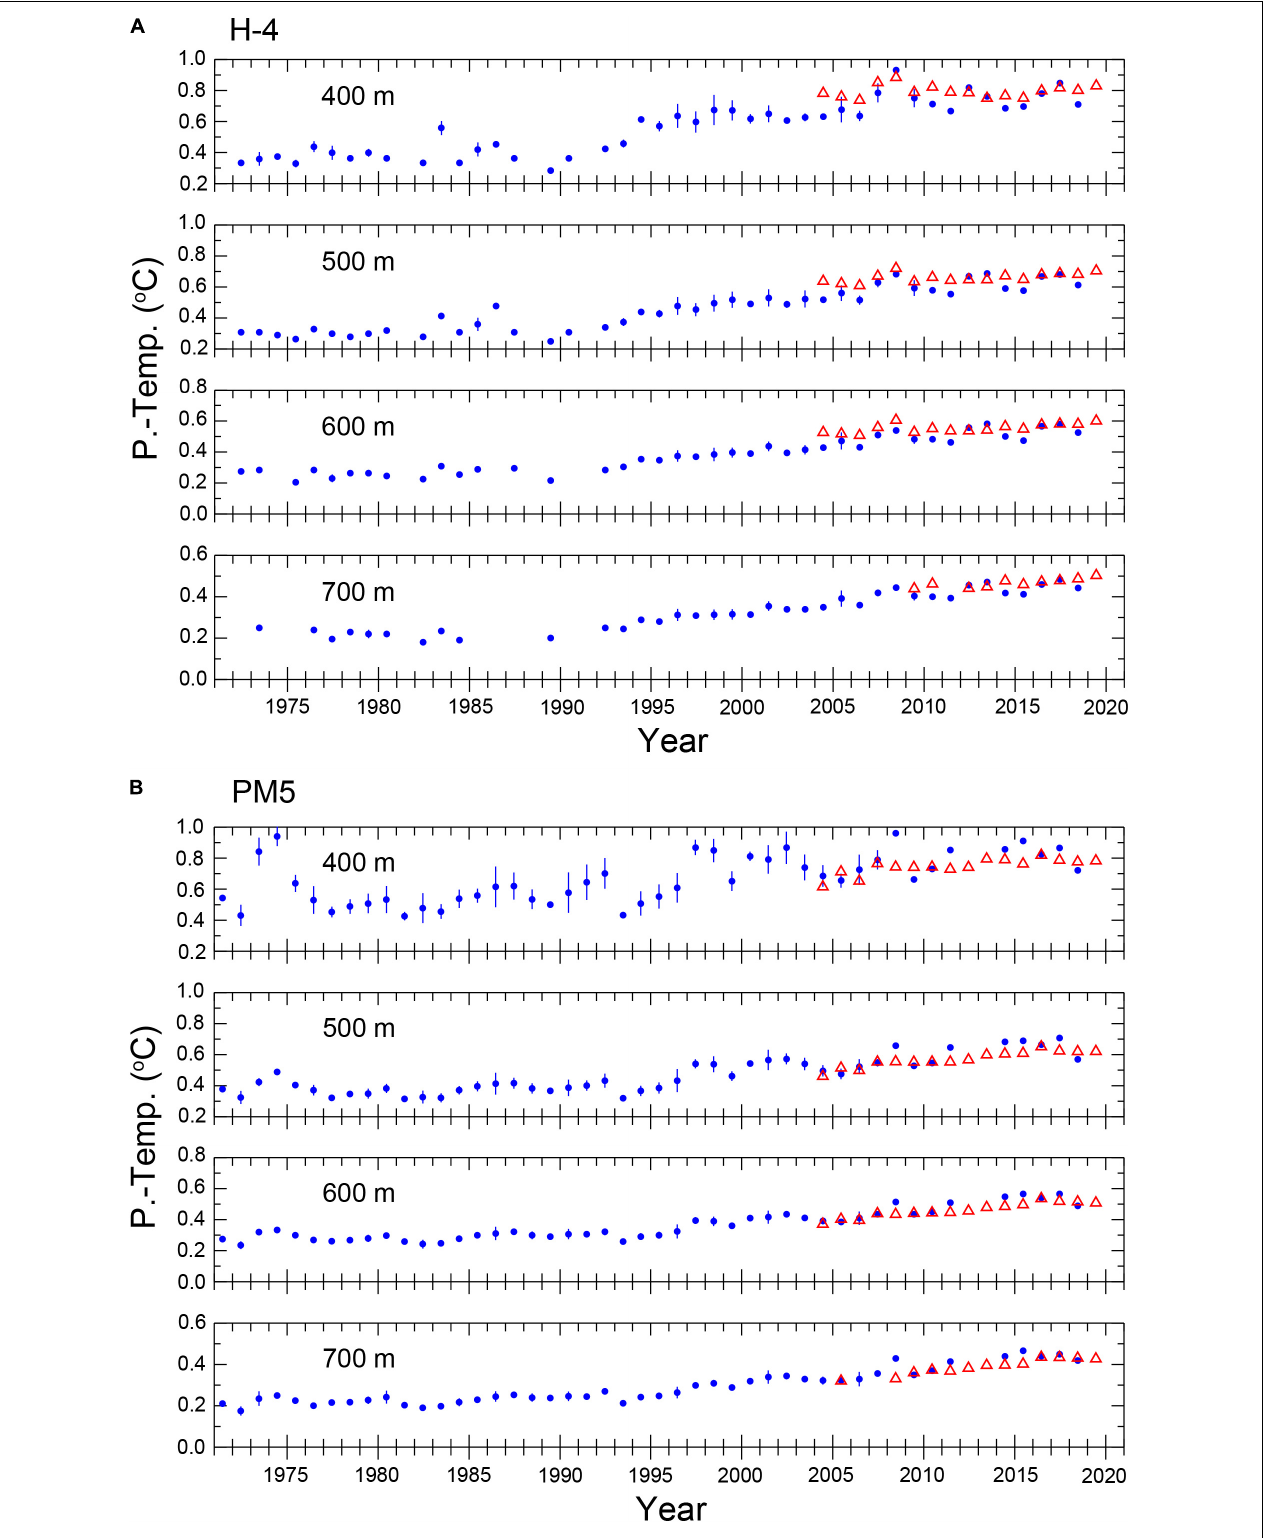
FIGURE 6 | Time series of the ship-based yearly mean PT at 400, 500, 600, and 700 m at (A) Stas. H-4 and (B) PM5. Vertical bars at each data point indicate one standard deviation. Red triangles in (A,B) indicate the Argo-based yearly mean PT in JE and YB, respectively.